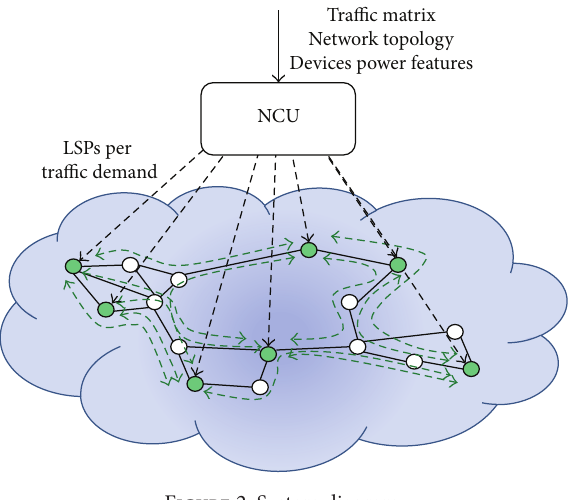
Figure 2: System